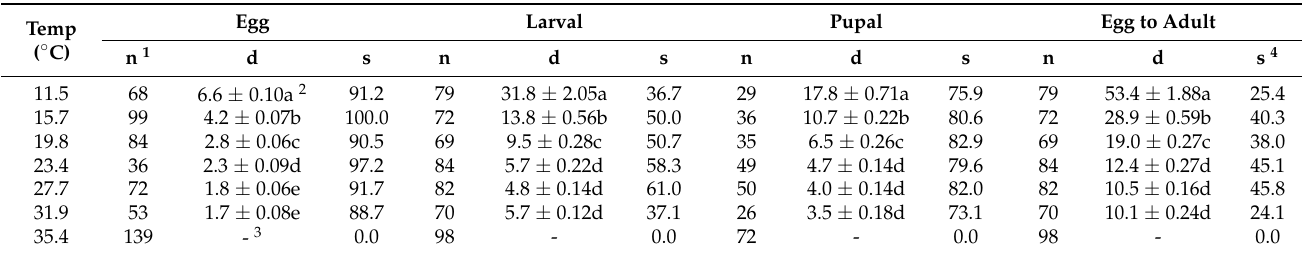
Table 1. Development time (d) (mean ± SE) in days and percent survival (s) of Feltiella acarisuga at constant tempera- tures